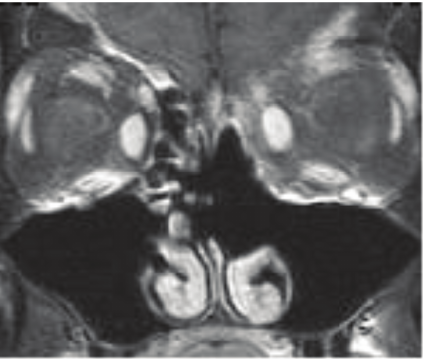
Figure 5: Coronal MRI 2 years after operation showing no residual or recurrent